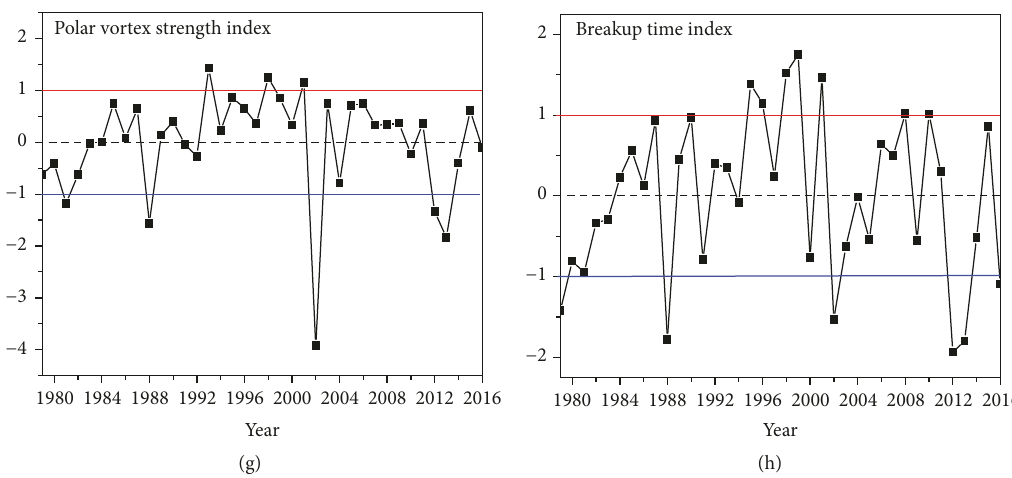
Figure5:(a)Theinterannualvariationsoftotalcolumnozoneintheinteriorofpolarvortex(units:DU),(b)polarvortexarea(units:10 6 km 2 ), and (c) polar vortex strength (units: m/s) in September (black curve), October (blue curve), and SO averaged (red curve), respectively. (d) The polar vortex breakup time (units: day) for the period 1979–2016. (e)–(h) Time series of detrend and normalized ozone, vortex area, strength, and breakup time index during the period 1979–2016. Values less than − 1.0 (blue line) or more than +1.0 (red line) are used to distinguish the vortex area, smaller/larger; strength, weaker/stronger; and breakup time earlier/later years, respectively.